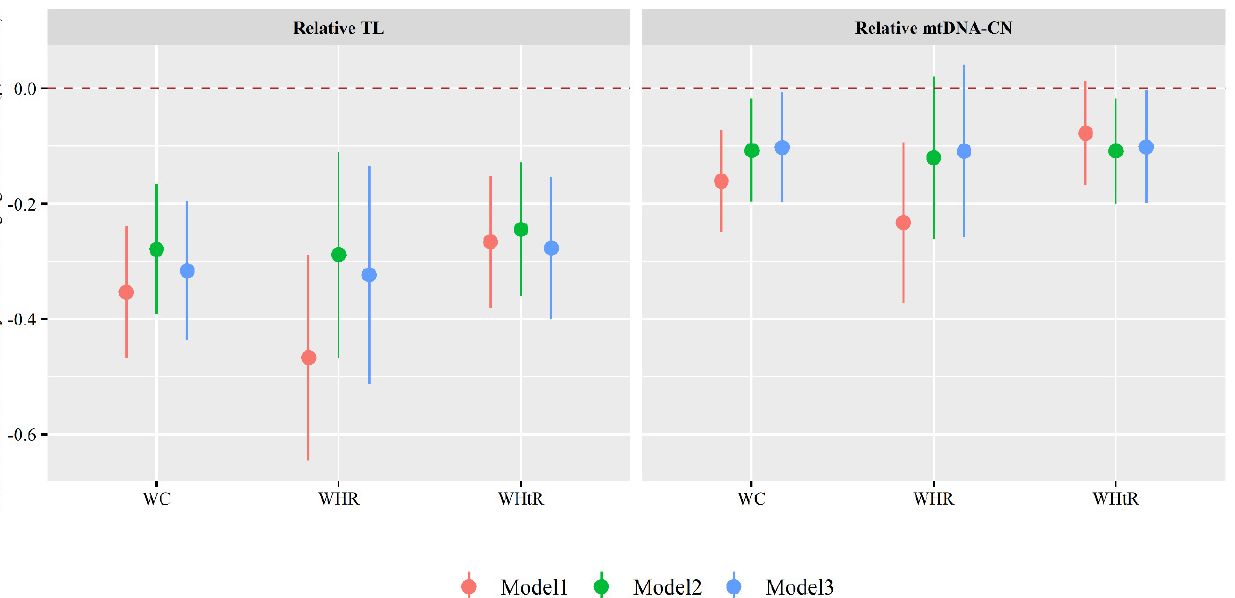
Figure 2. Spearman rank correlation between obesity indices and platelet traits. MPV: mean platelet volume; PCT: plateletcrit; PDW: platelet distribution width; P-LCR: platelet large cell ratio; WC: waist circumference; WHR: waist-to-hip ratio; WHtR: waist-to-height ratio.